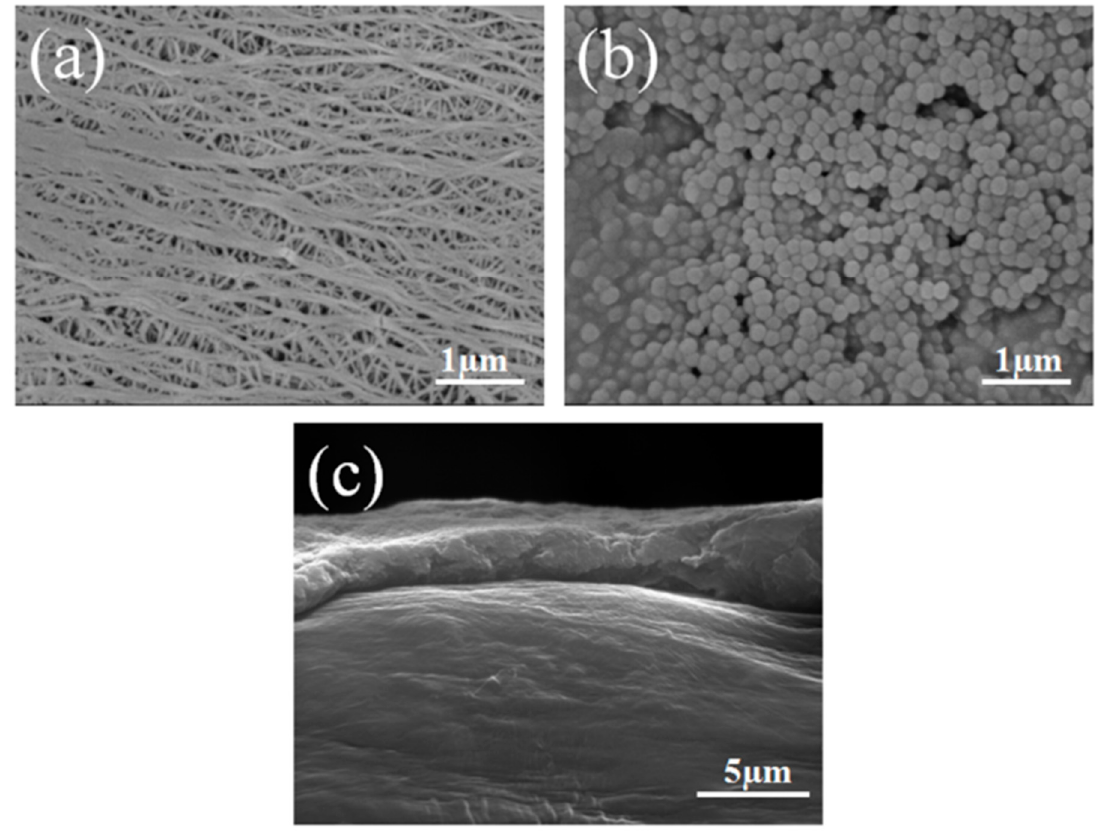
Figure 1. SEM photographs of ( a ) the bare PE separator; ( b ) the PE-PVDF separator; ( c ) the cross section of PE-PVDF separator.